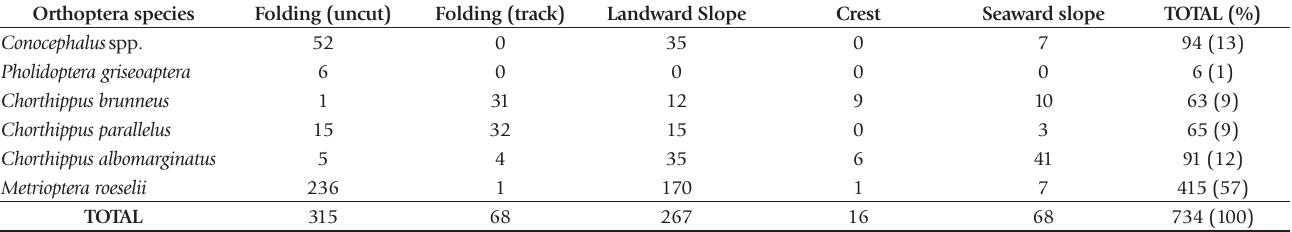
Table 3. Orthoptera abundances recorded from five sections of a seawall (Brightlingsea, UK) using quadrat sampling (Gardiner et al. 2015).